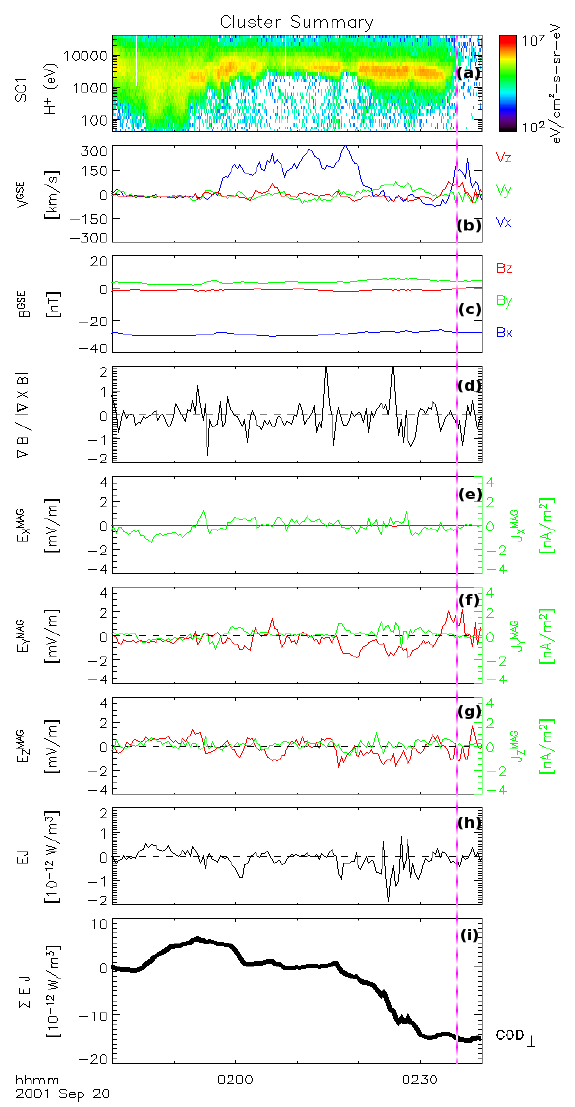
Fig. 7. Summary of Cluster data for the time interval 01:40–02:40: (a) CODIF H + energy spectrogram from SC1; average (b) H + ve- locity and (c) magnetic field; (d) normalized divergence of the mag- netic field, ∇· B / |∇× B | ; (e–g) components of the electric field, as derived from CODIF data, and current density, in the MAG refer- ence system; (h) E · J and (i) its cumulative sum. The velocity, as well as the electric field, are averaged over SC1, SC3, and SC4. The magnetic field is averaged over all spacecraft. The conjunction with FAST is indicated by the vertical magenta line.